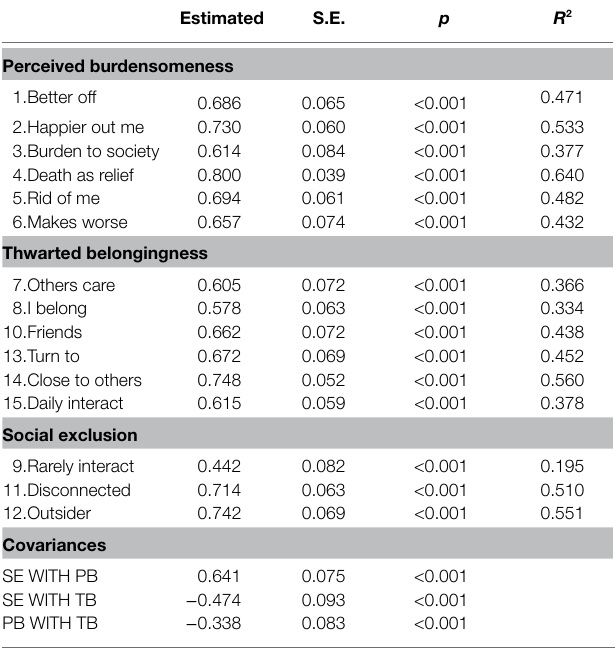
TABLE 4 | Estimated parameters for the three-factor model. Estimated